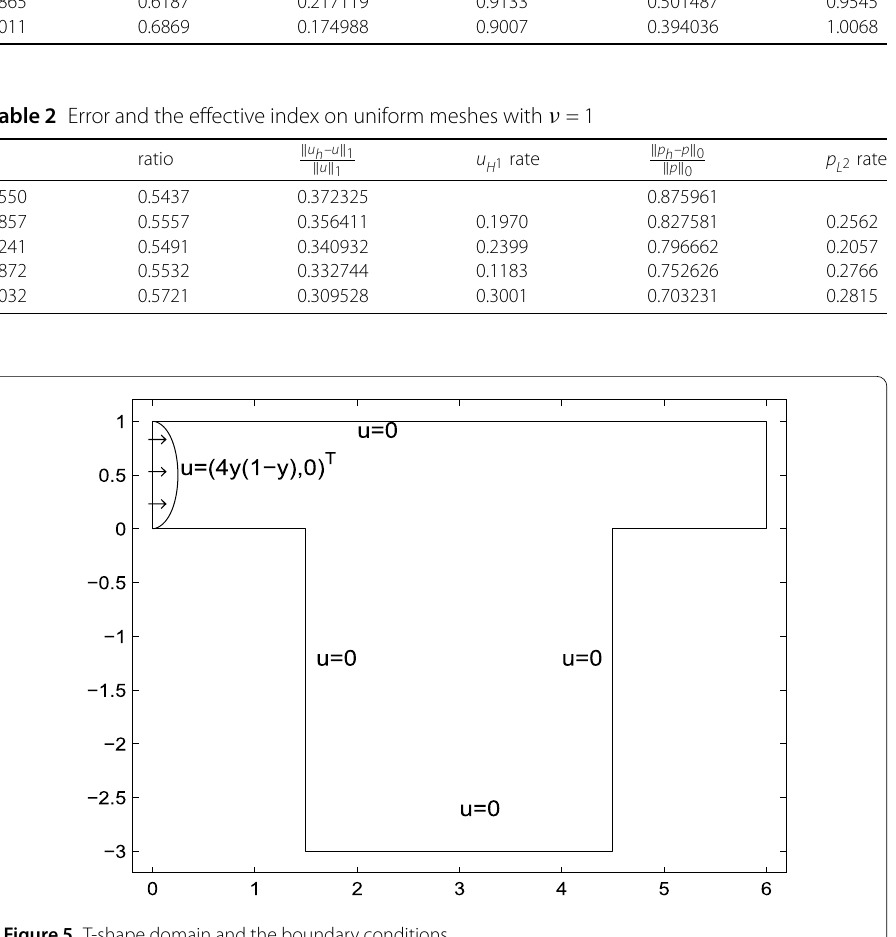
Figure 5 T-shape domain and the boundary